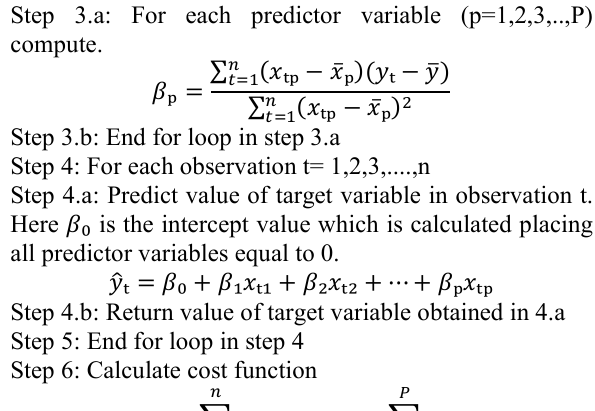
Figure 3. Flowchart of used regression